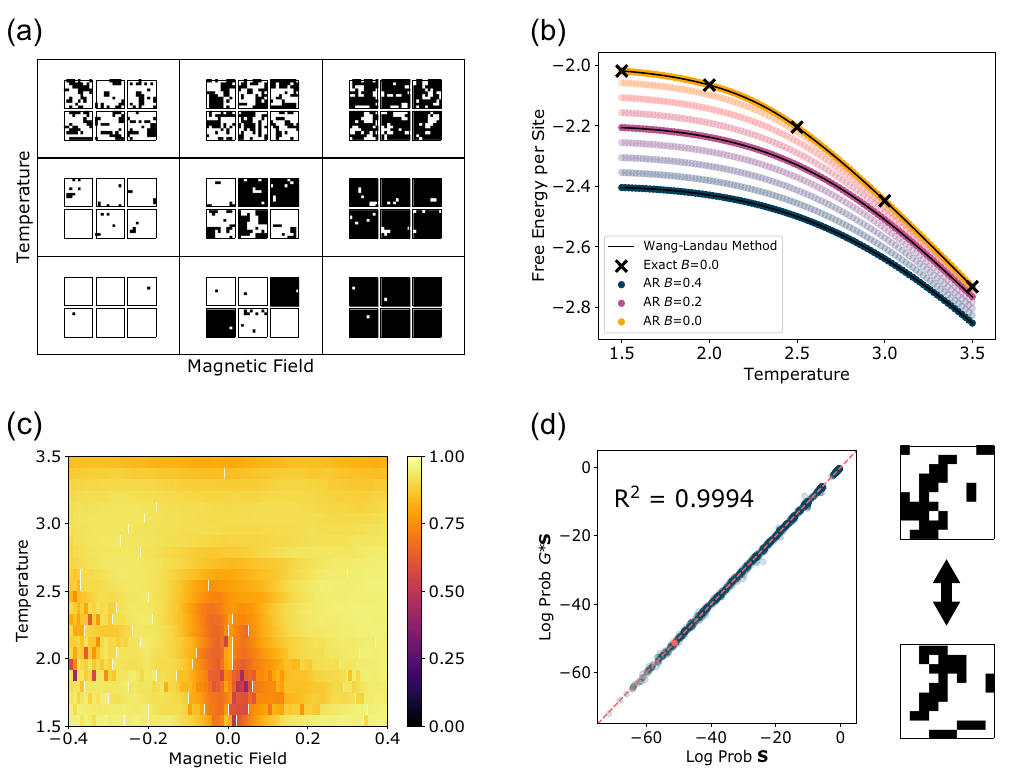
Fig. 2 SEGAL model for Ising alloy. a Samples from SEGAL under varying constraints T ∈ [1.5, 2.5, 3.5], B ∈ [ − 0.4, 0.0, 0.4]. b Numerical comparison between self-normalized importance sampling (SNIS) from SEGAL, Wang – Landau method 39 – 41 , and exact solutions 43,44 with B = 0.0. Colors with lower opacity are sampled at intermediate values of B ∈ [0.05, 0.10, 0.15, 0.25, 0.30, 0.35]. SEGAL can interpolate over the whole training region. c Normalized effective sample size (NESS) over the training region. Estimates of NESS are taken with 10,000 samples each. d (left) Symmetry invariance of SEGAL model under an operation G . (right) An example of a transformed con fi guration with probabilities corresponding to the red dot on the